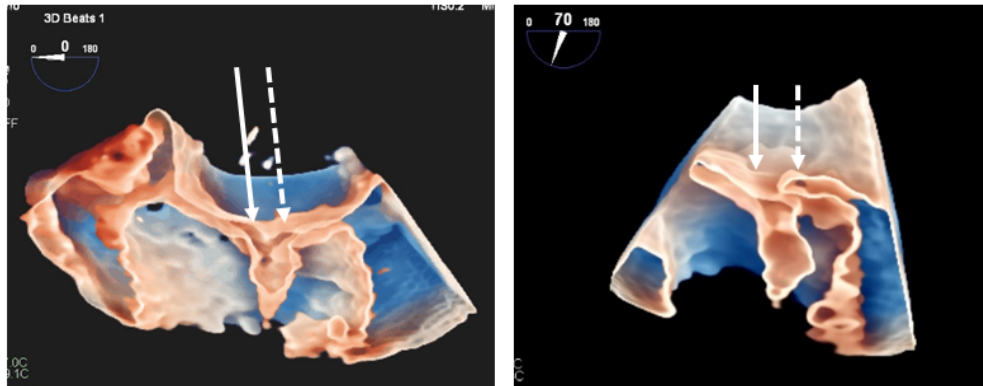
Figure 6. Two examples of grasped leaflet visualization with 3DTEE in transillumination plus transparency modality. Left panel: both anterior (arrow) and posterior (dotted arrow) leaflet are perfectly grasped by the clip in this patient. Right panel: In this case the anterior leaflet is well grasped while the posterior leaflet (dotted arrow) has not been captured.